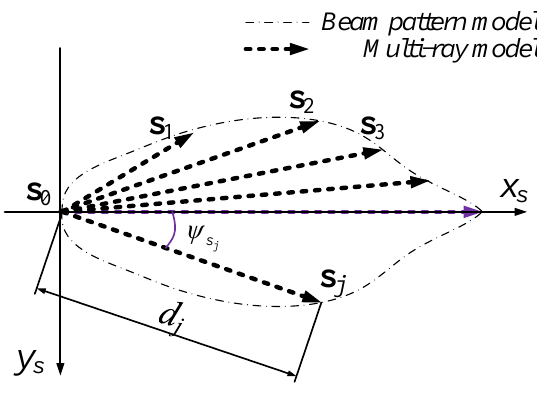
Figure 5. The sonar coordinate system and the multi-ray model of